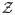
Model schematic.Model fitting was performed separately for each country or territory. The subscript i indicates administrative unit i within a modeled country. The subscript x represents either the total population (x = T) or pregnant women only (x = P). The top row represents the different data types (C = confirmed cases, S = suspected cases, G = Guillan-Barré syndrome cases, M = microcephaly cases). The second row includes the latent variables (Z = Symptomatic infections, and I = Infections). The third row includes the symptompatic probability (ρZ), the reporting probabilities for confirmed cases (ρCx,i) and suspected cases(ρSx), the probability that a symptomatic infection leads to a reported GBS case (ρG), and the probability that a ZIKV infection in a pregnant woman leads to a reported microcephaly case (ρM). The parameters in the bottom row are the hyperparameters for the reporting probabilities ρCx,i and ρSx,i. See text and S2 Table for description of model parameters and variables.